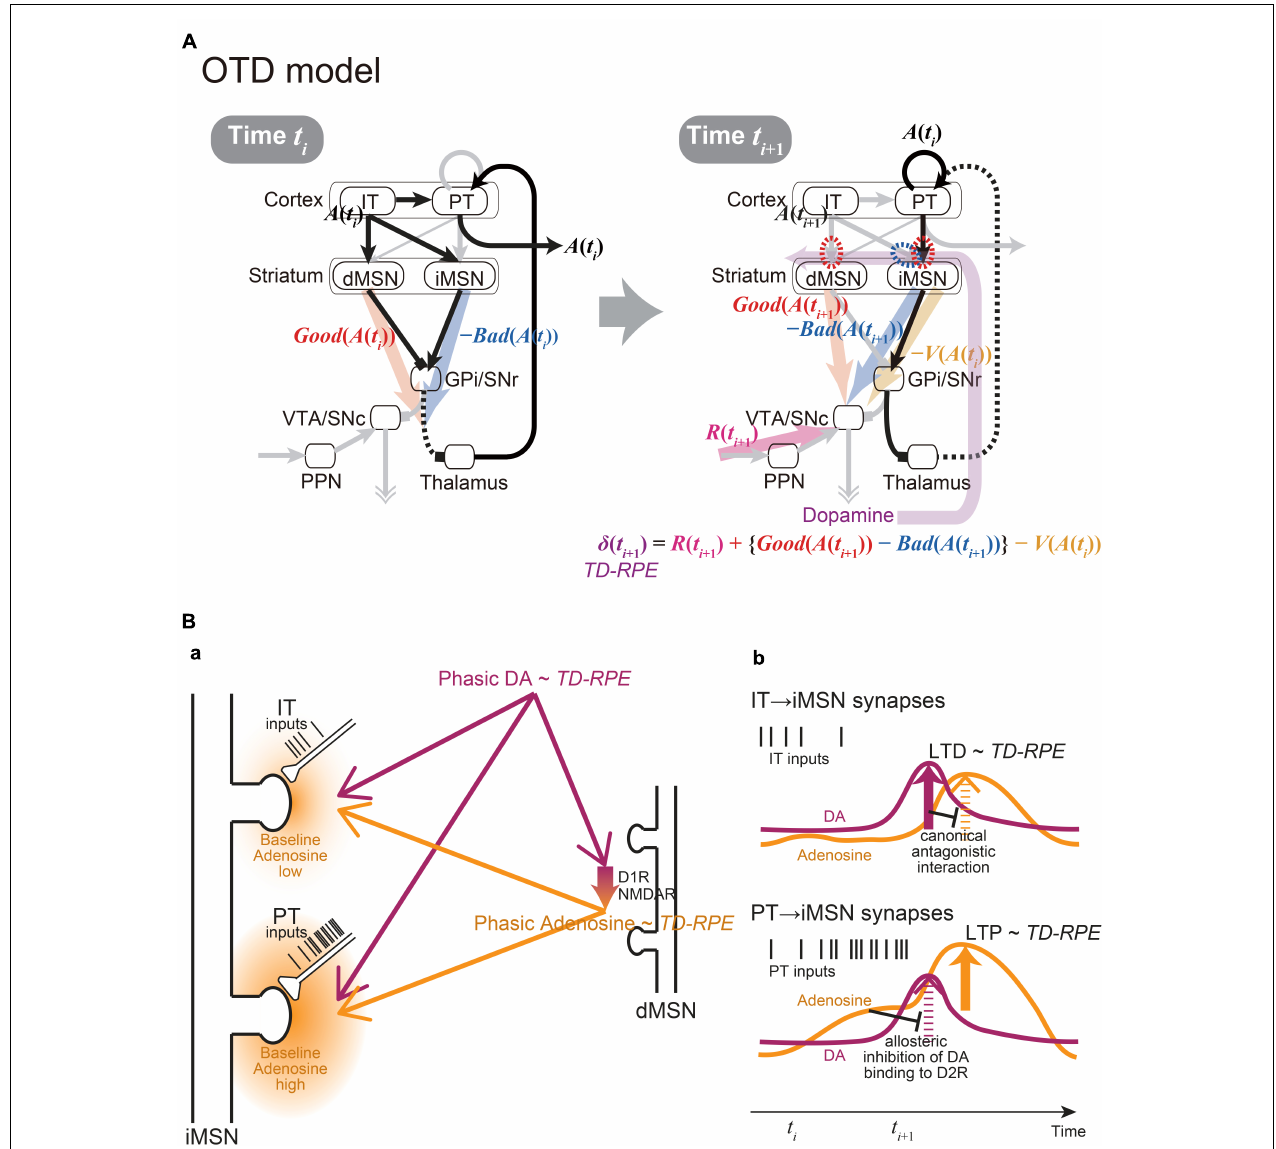
FIGURE 2 | The integrated Opponency and Temporal-Difference (OTD) model, and the hypothetical mechanism for opposite directions of plasticity at IT → iMSN synapses and PT → iMSN synapses upon phasic DA release. (A) The OTD model. See the main text for explanation. (B) The hypothetical mechanism for opposite directions of plasticity at IT → iMSN synapses and PT → iMSN synapses. (a) A schematic diagram. The PT inputs are presumably more sustained and intense than the IT inputs, resulting in low and high baseline adenosine levels around the IT → iMSN synapses and PT → iMSN synapses, respectively. PT axospinous terminals on MSNs have been shown to be typically larger than IT axospinous terminals (Reiner et al., 2003; Reiner et al., 2010), as illustrated here, although IT axospinous terminals on iMSNs are larger than those on dMSNs (Deng et al., 2015). Phasically released DA that represents TD-RPE reaches both types of synapses similarly, while at the same time, it causes phasic adenosine release, which also reflects TD-RPE, via D1 and NMDA receptors on dMSNs. (b) Hypothesized time courses of DA (purple lines) and adenosine (orange lines) at IT → iMSN synapses (top panel) and PT → iMSN synapses (bottom panel). At IT → iMSN synapses, where the baseline adenosine level is low, phasic DA causes D2 receptor signaling, leading to LTD whose magnitude is proportional to TD-RPE. The D2 receptor signaling then inhibits A2A receptor signaling in response to phasic adenosine through canonical antagonistic interaction at the level of adenylyl cyclase. In contrast, at PT → iMSN synapses, high concentration of baseline adenosine allosterically prevents D2 receptor signaling to occur in response to phasic DA. Then, A2A receptor signaling occurs in response to phasic adenosine, leading to LTP whose magnitude is proportional to TD-RPE.